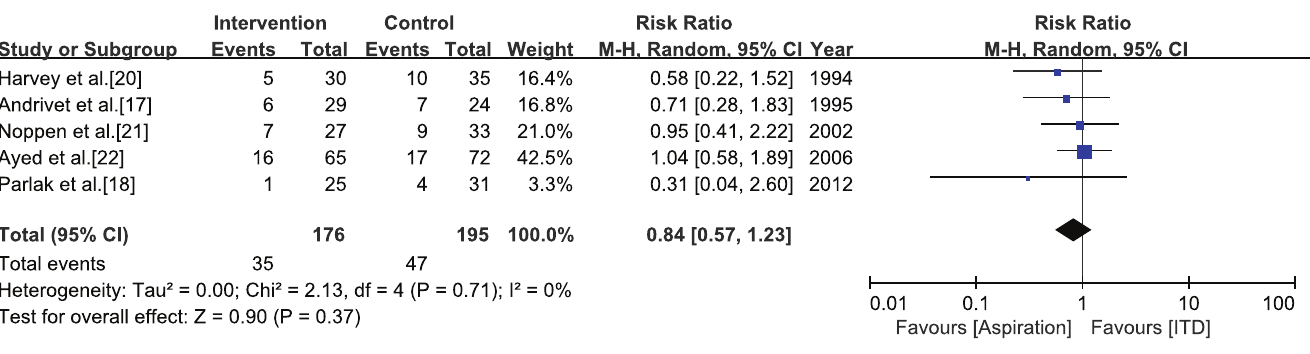
Fig 4. Meta-analysis of the recurrencerate within 1 year associated with aspiration versus intercostal tube drainage.